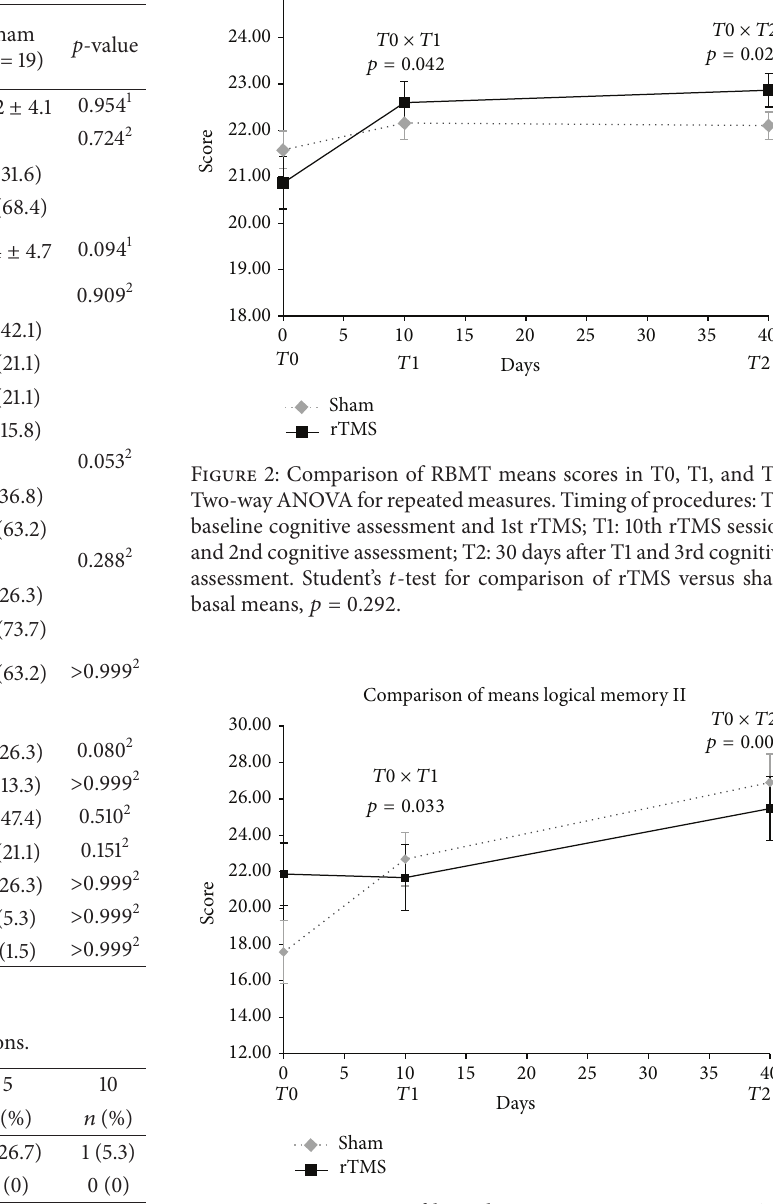
Table 5: Demographic data.